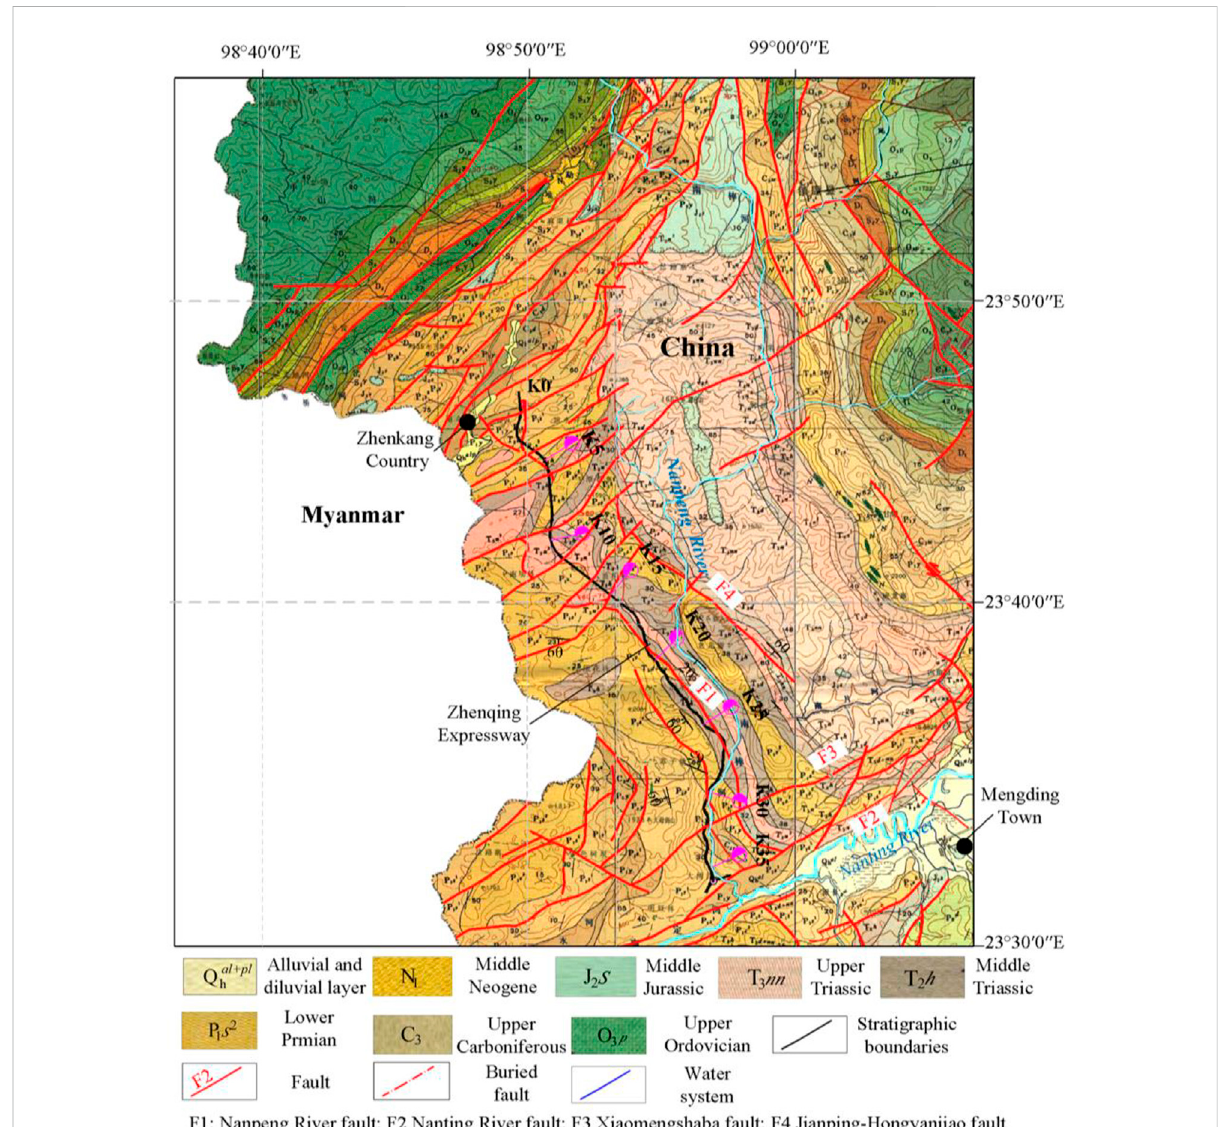
Main strata and faults in the research